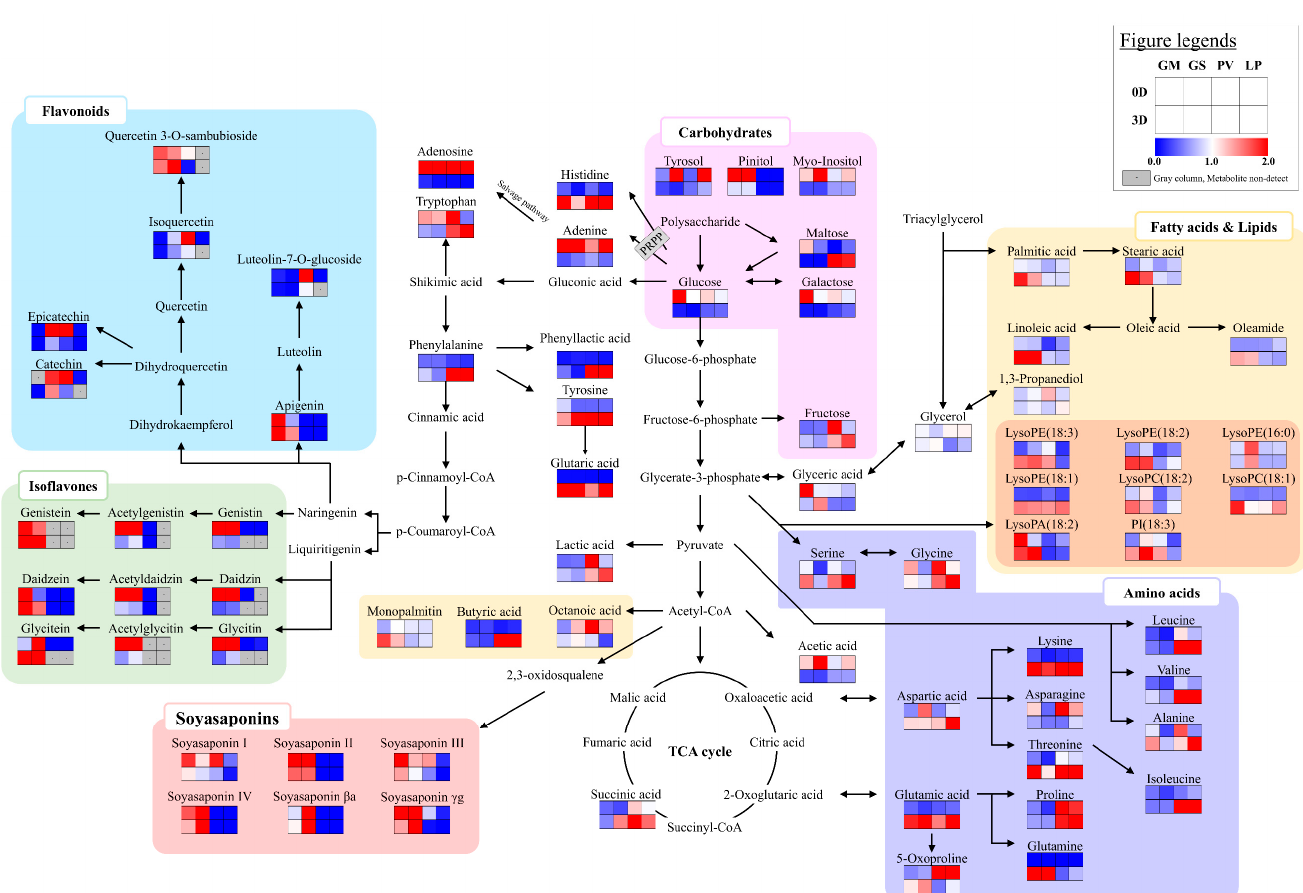
Figure 4. The pathway and heatmap analysis for the metabolites in the four beans that were fermented with A. oryzae 0 d and 3 d after fermentation. The metabolite pathways were adopted from the KEGG database. The colors symbolize relative abundance. GM: G. max , GS: G. soja , PV: P. vulgaris , LP: L. purpureus , 0D: 0 day of fermentation, 3D: 3 days after fermentation .